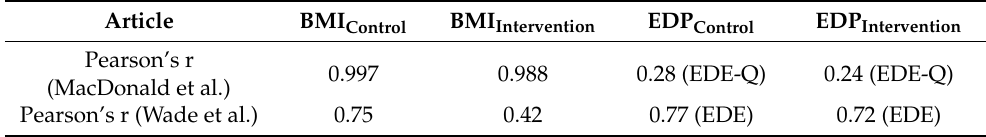
Table 1. The correlation coefficients (Pearson’s r) provided by MacDonald et al. [29] and Wade et al. [28]. Article BMI Control BMI Intervention EDP Control EDP Intervention Pearson’s r 0.997 0.988 0.28 (EDE-Q) 0.24 (EDE-Q) (MacDonald et al.) Pearson’s r (Wade et al.) 0.75 0.42 0.77 (EDE) 0.72